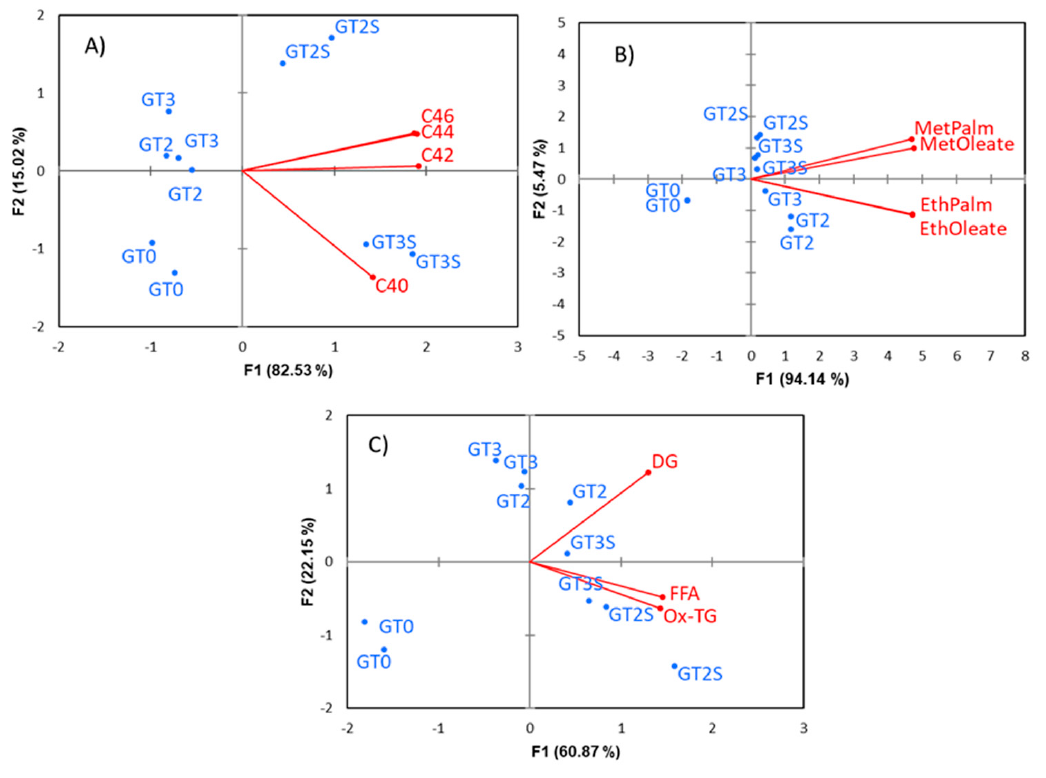
Figure 7. A study, based on the original data of the changes, according to processing phases and extraction method in the minor components in green Spanish-style fat using Multiple Factor Analysis (MFA): PCA was done according to minor component groups. Waxes ( A ), alkyl esters ( B ) and polar compounds ( C ). GT0, GT2 and GT3 are oils extracted from the fresh, fermented and packaged olives, respectively. Samples coded S were extracted by Soxhlet; otherwise, they were extracted by Abencor. See Table 1 for abbreviations.